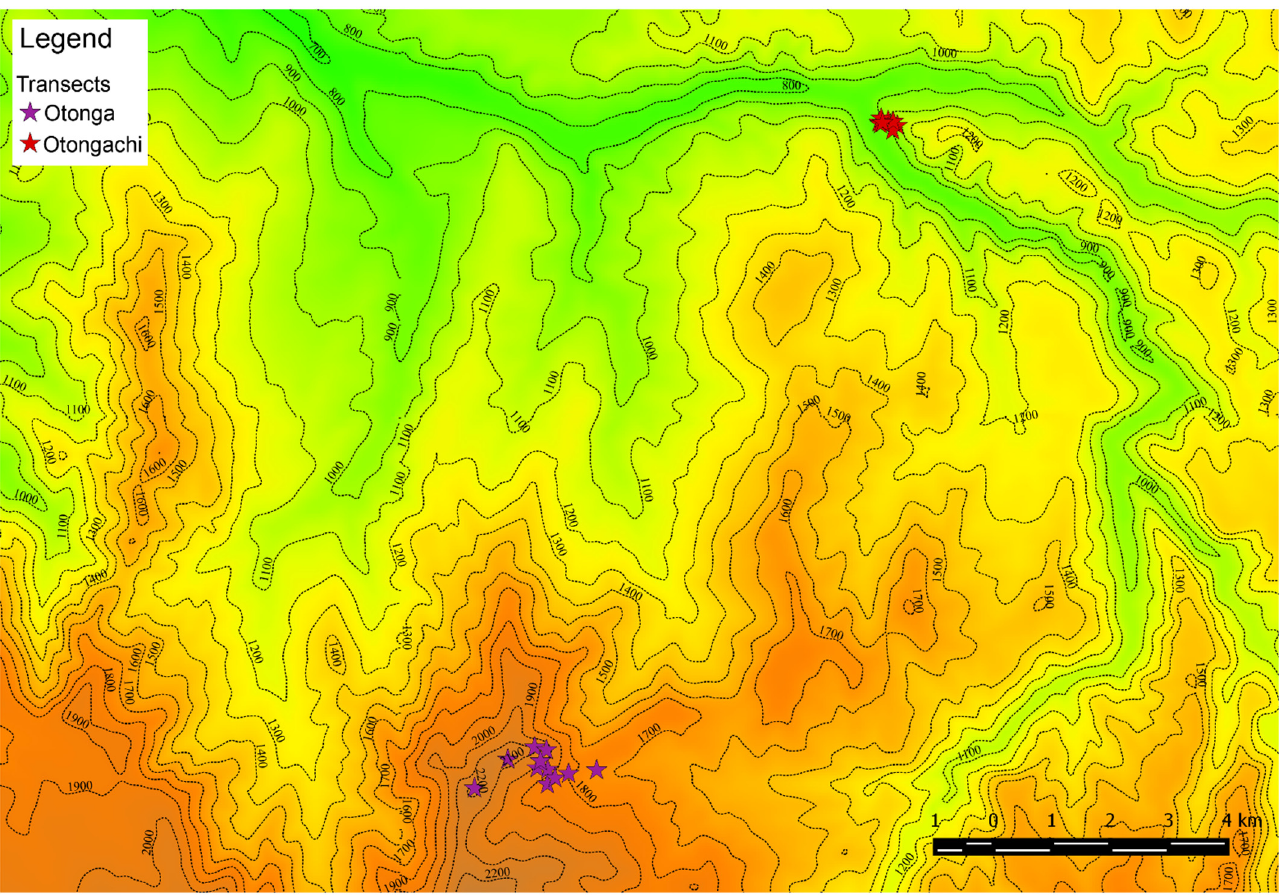
Figure 2. Localisation of the transects.